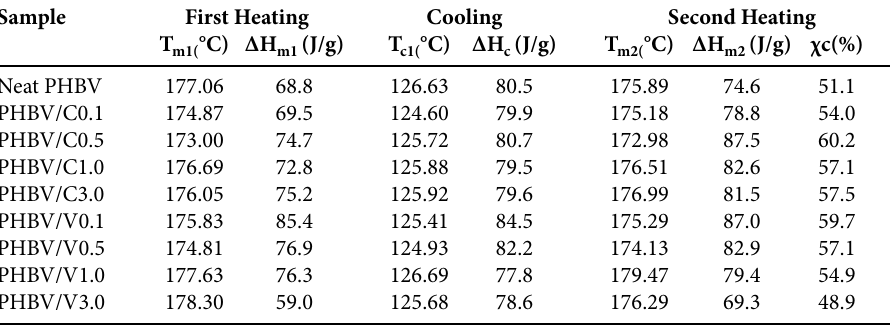
Table 4. Thermal properties obtained from DSC curves for polymer composites